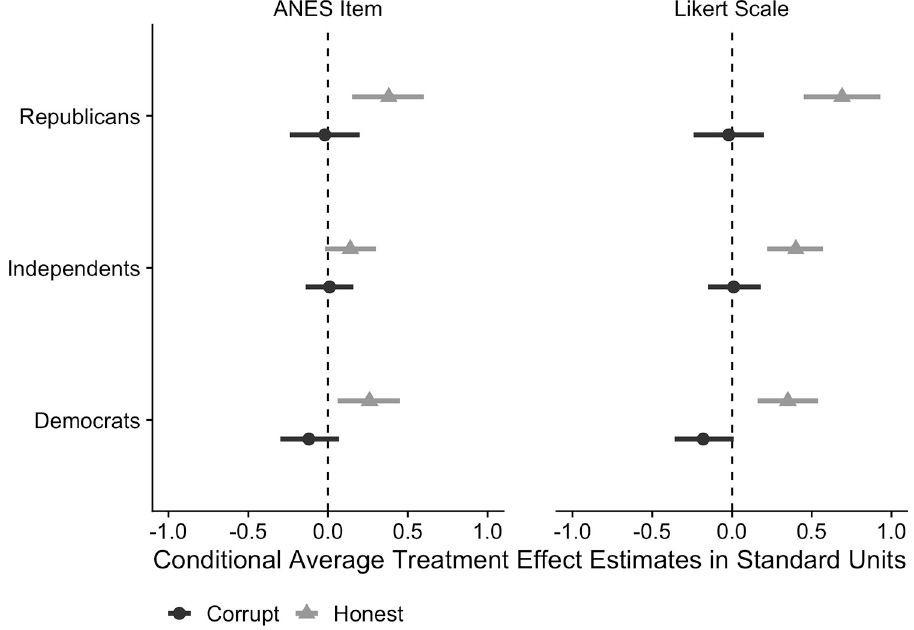
Fig 3. Estimated effects of Corrupt and Honest treatments by party identification and outcome